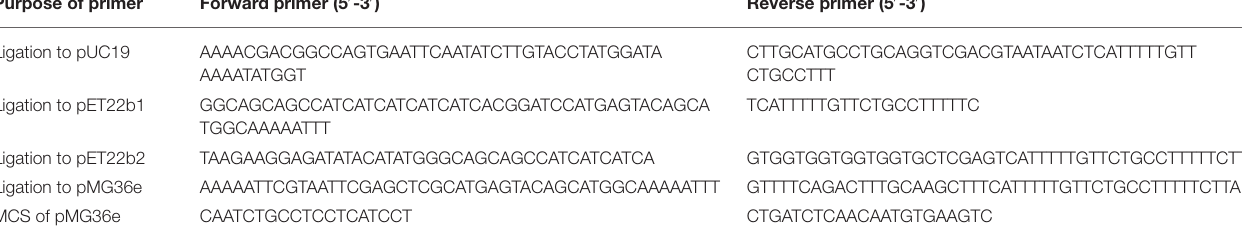
TABLE 1 | Primers used in this study. Purpose of primer